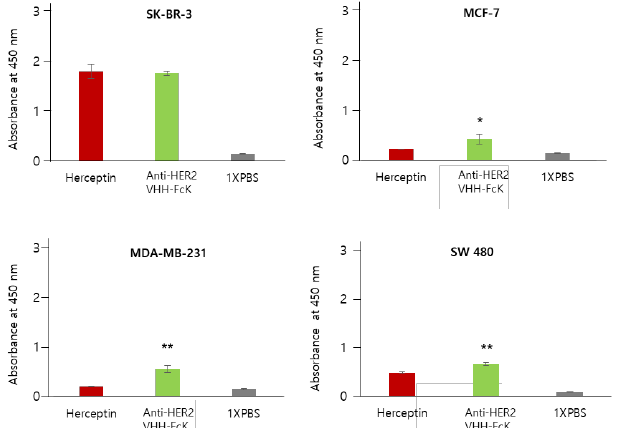
Figure 4. Comparison of the specific binding activity of Herceptin and the anti-HER2 VHH-FcK P to breast cancer cell lines SK-BR-3, MCF-7, and MDA-MB-231, and the colorectal cancer cell line, SW480. Herceptin and plant-derived anti-HER2 VHH-FcK were applied to ELISA 96-well plates seeded with breast cancer cell lines SK-BR-3, MCF-7, and MDA-MB-231 and the colorectal cancer cell line, SW480 (4 × 10 5 cells / 100 µ L). The di ff erence between anti-HER2 VHH-FcK P and Herceptin were compared statistically (** p < 0.01, * p <